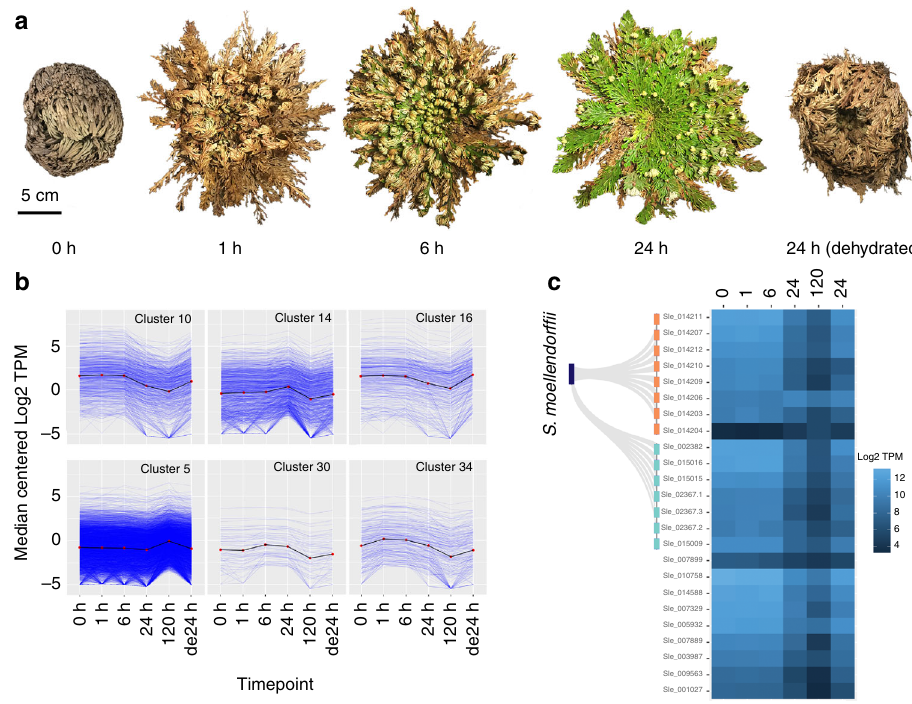
Fig. 4 Genomic features of the rehydration and desiccation processes. a Overview of sampling for the rehydration and desiccation time course. Samples were taken from plants that were desiccated for 3 years (0), 1, 6, and 24 h post rehydration (recovery), 120 h post rehydration (fully recovered), and after a 24 h dehydration (de24 h). b Scaled transcript expression pro fi les (in transcripts per million, TPM) of representative gene co-expression clusters with decreased (10, 16, 34) and increased expression (5, 14, 34) during rehydration. c Heatmap of log2 transformed early light-induced protein (ELIP) expression with the two arrays of tandem duplicated genes in S. lepidophylla orthologous to the only ELIP in to S. moellendorf fi i highlighted on the